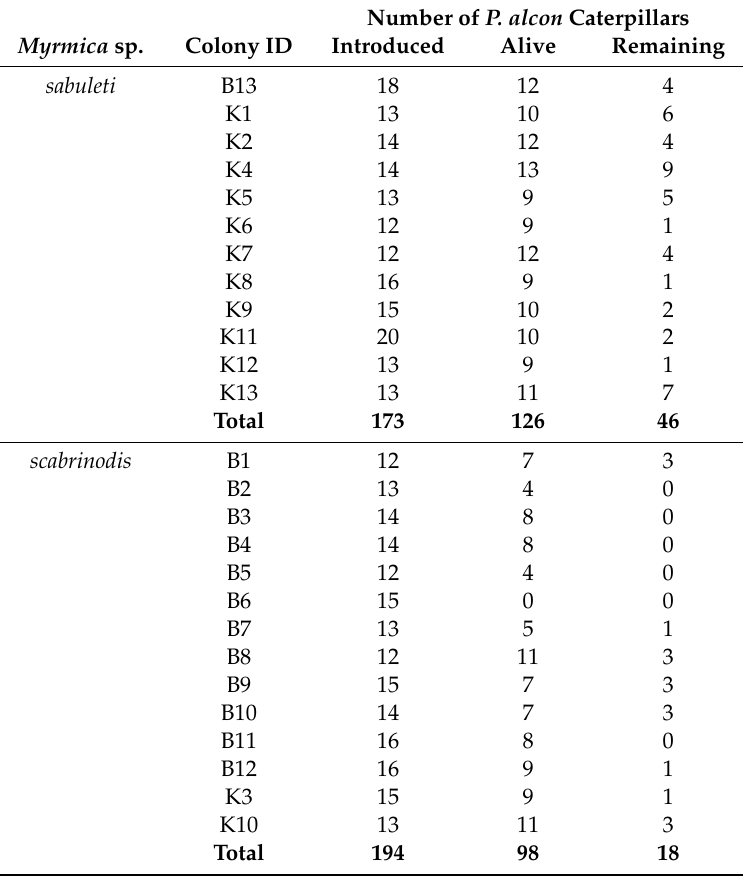
Figure 2. Graphical summary of the experimental set-up (see Sections 2.2 and 2.3 for details). Table 1. The number of pre-adopted Phengaris alcon caterpillars introduced to the Myrmica sabuleti and M. scabrinodis nurse colonies, the number of caterpillars alive at the start of the tests, and the number of caterpillars remaining in the nurse colonies after the experiments were established (i.e., after 4 or 8 caterpillars were used for the experimental set-up—see Table A1).